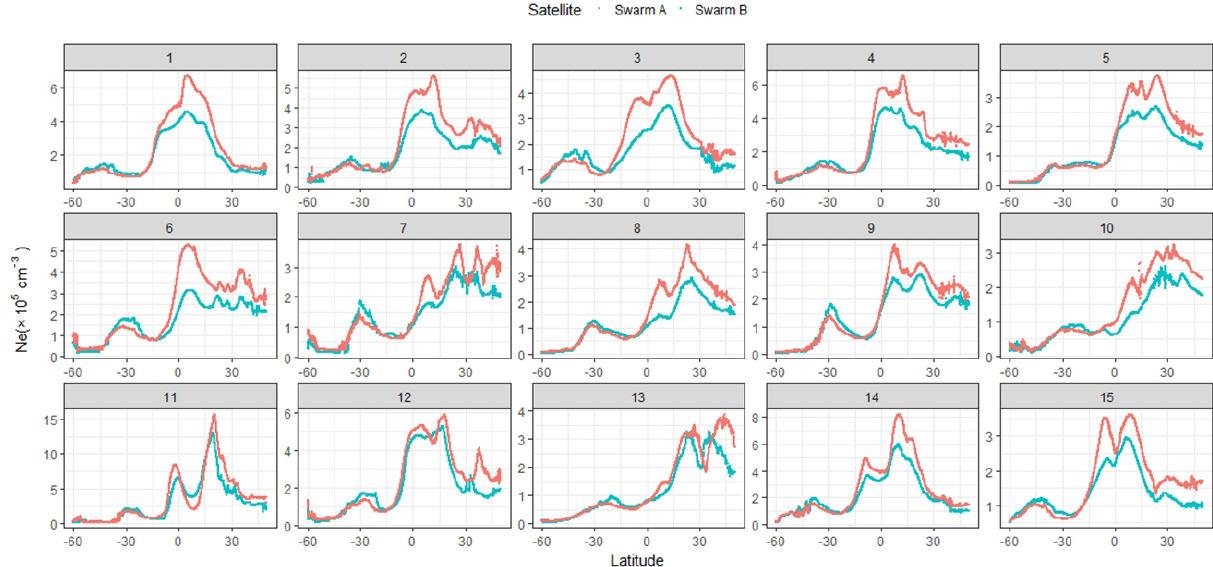
Figure 6. Examples of stratification in southern